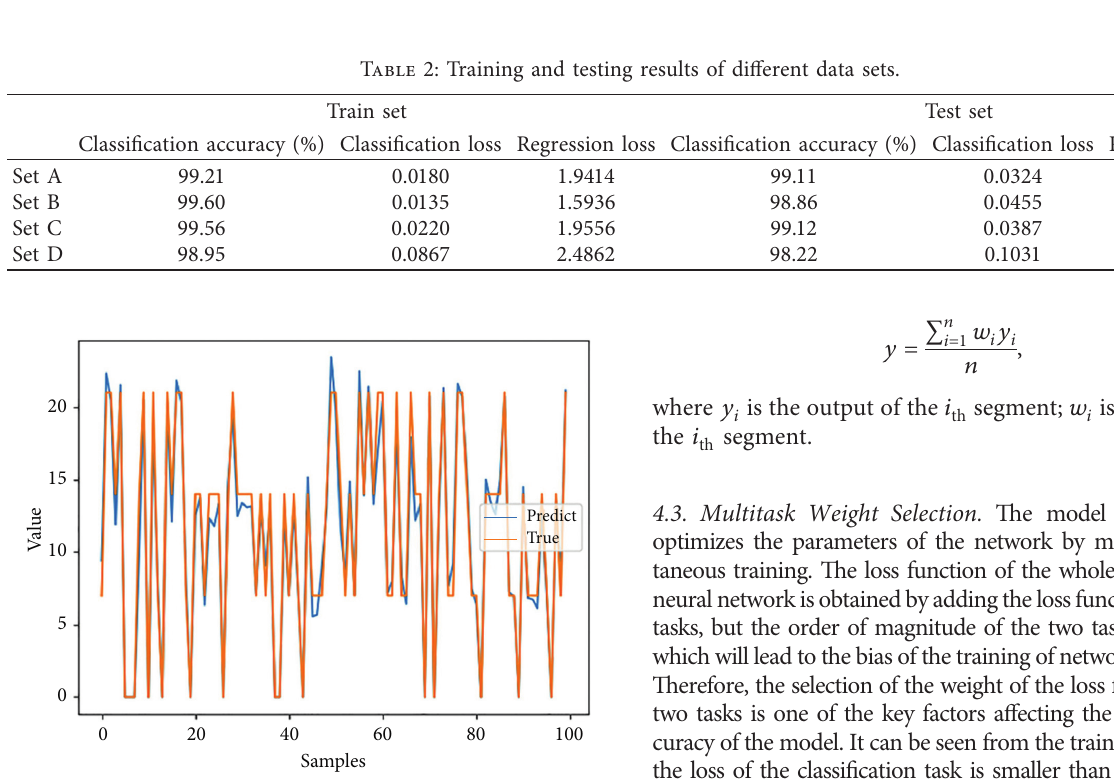
Figure 3: Prediction result of fault